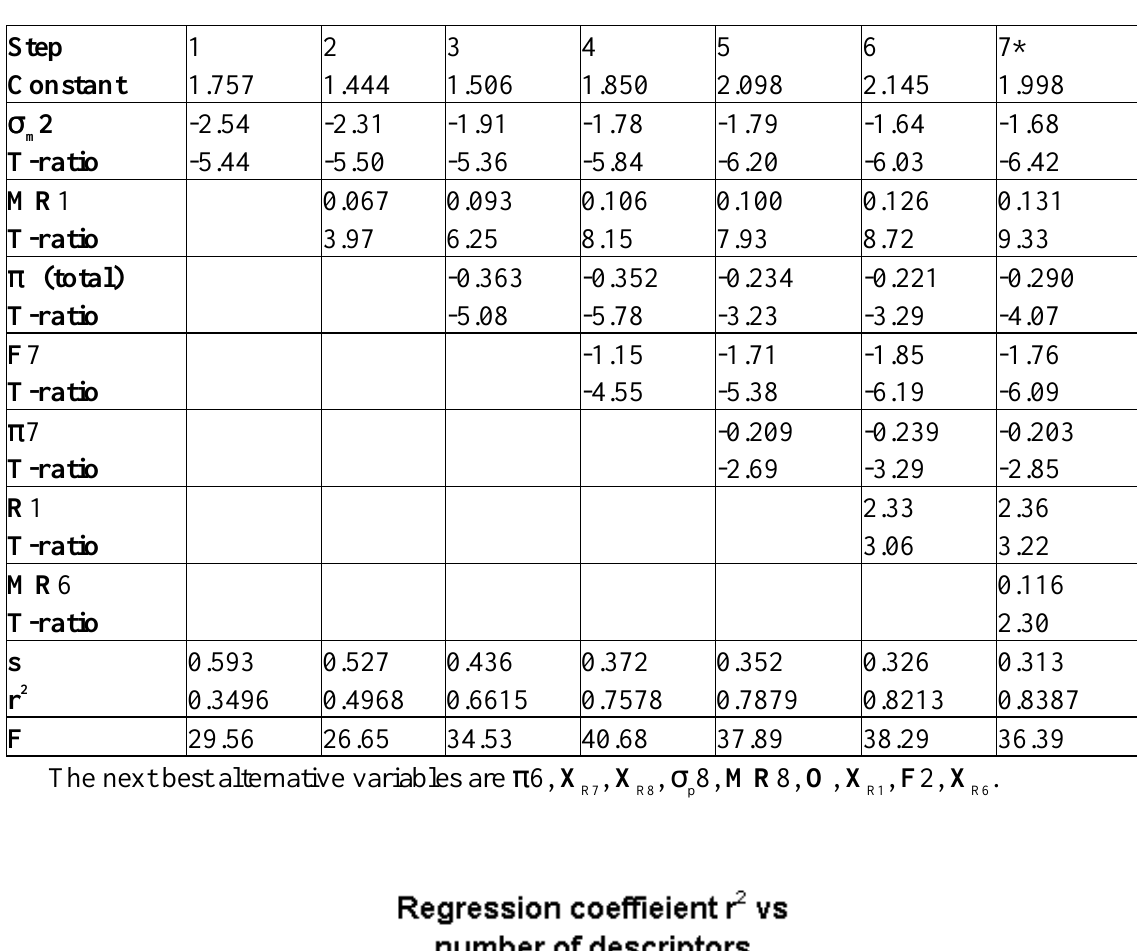
on 23 predictors, with n = 57 50